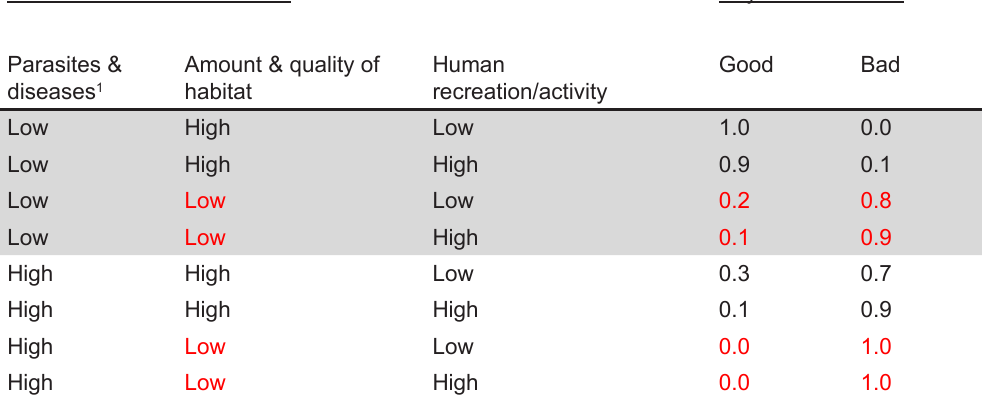
Table A6. Conditional probability table for node physical condition of caribou. Parent nodes and their state